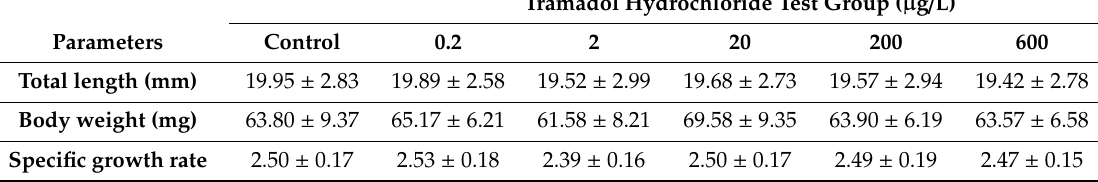
Table 2. Results of morphological parameters at the end of experiment. Data are expressed as mean ± standard deviation. No significant di ff erences ( p > 0.05) were found between control and experimental